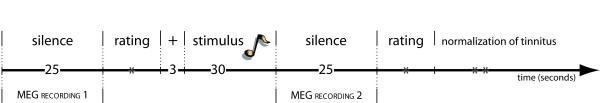
MEG data acquisition, example trial. This figure illustrates one of 20 trials (including 4 practice trials) every participant worked on. During the first 25 s of silence, the pre measure was obtained with MEG recording 1. A fixation cross was then followed by the presentation of one of the individually different – depending on results of the pilot study – sound stimuli (RI or CO stimulus). During the next period of silence MEG recording 2 was obtained, which was used as post measure. The mean tinnitus loudness rating (0 = tinnitus is inaudible, 10 = tinnitus is of usual loudness) refers to the preceding period of silence during which recording 2 was taken. After the second rating the participant indicated when the tinnitus reached its usual loudness again. This then started the next trial. *No time limit, fast response desired; ** time limit: 4 min.